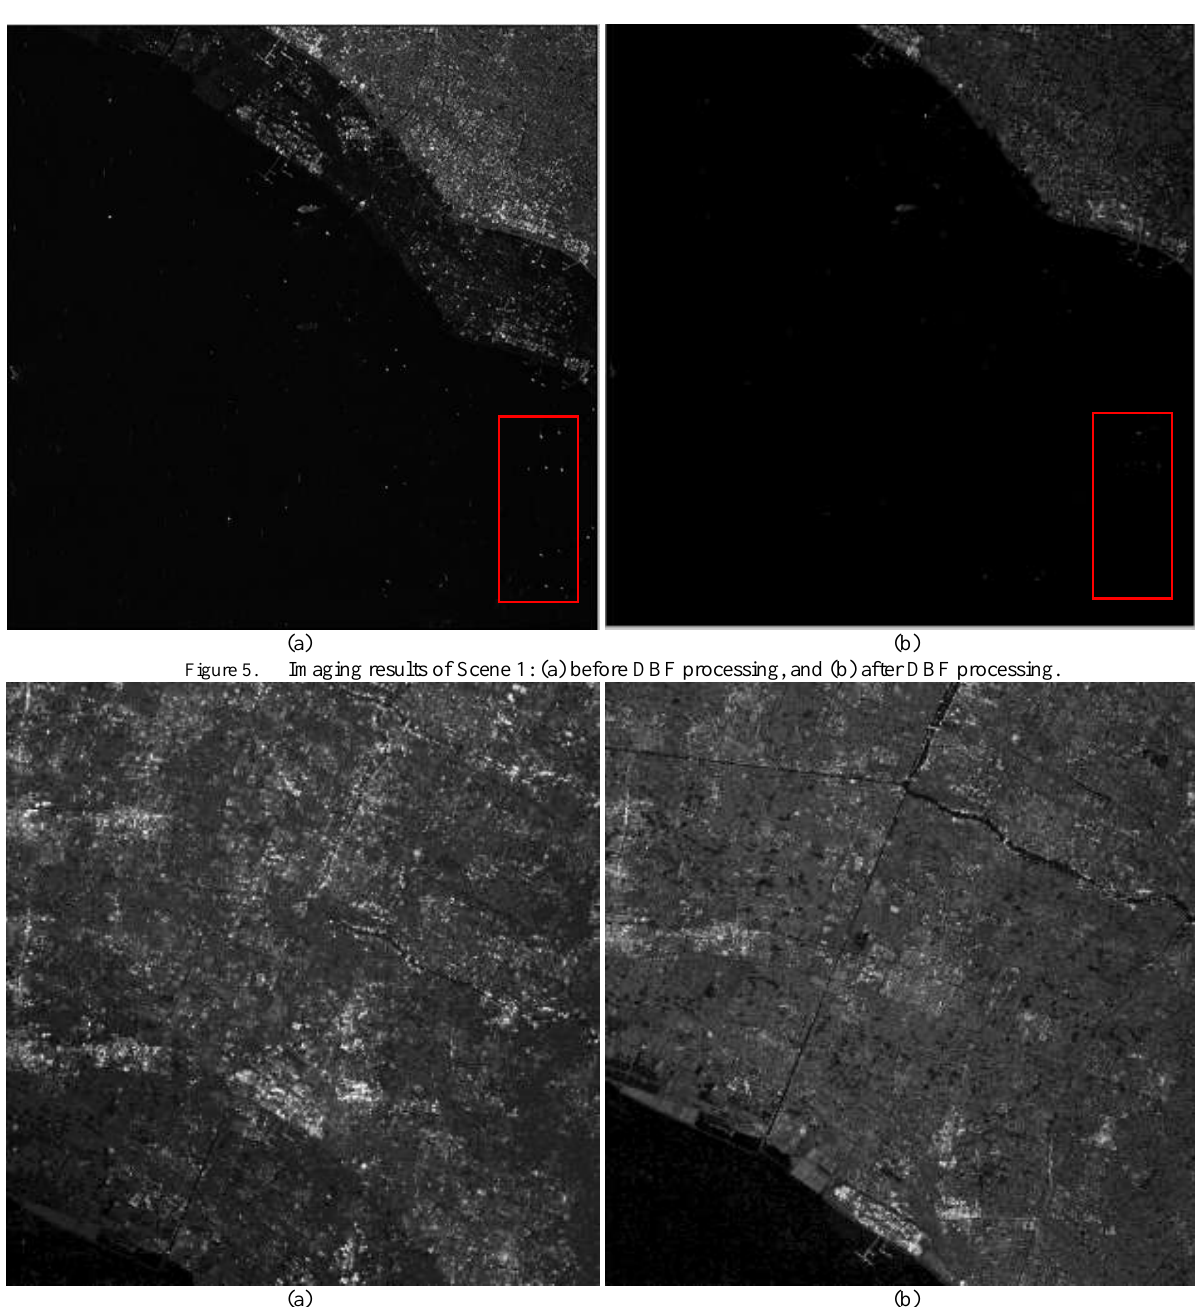
Figure 5. Imaging results of Scene 1: (a) before DBF processing, and (b) after DBF processing.